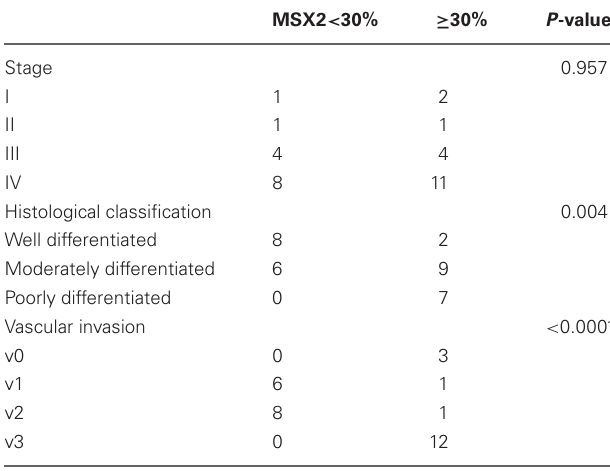
Table 2 | Correlation between clinicopathologic findings and MSX2 expression (Satoh et al.,